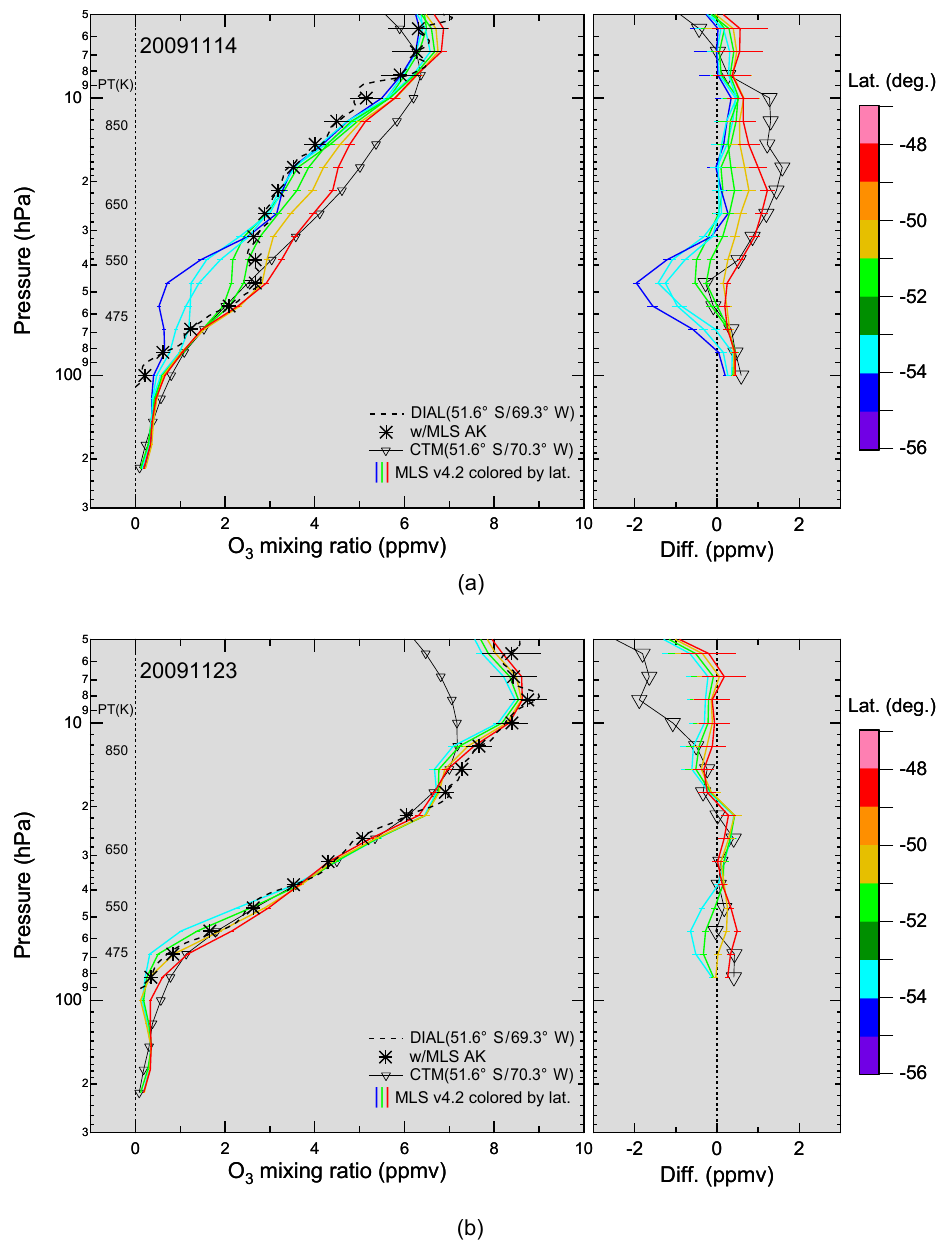
Figure 2. Vertical profiles of O 3 mixing ratios on 14 November 2009 (a) and 23 November 2009 (b) measured using DIAL (asterisks and dotted line) and MLS (solid lines with color) over the OAPA site (see text for additional description). A MIROC-CTM O 3 profile of the nearest grid for the OAPA site is also shown. Corresponding potential temperatures for pressure are shown as text in the vertical axis. Differences between DIAL and X (MLS or MIROC-CTM) ( X − DIAL) are shown in the right panel (see text). The MLS profiles are color coded based on their measurement